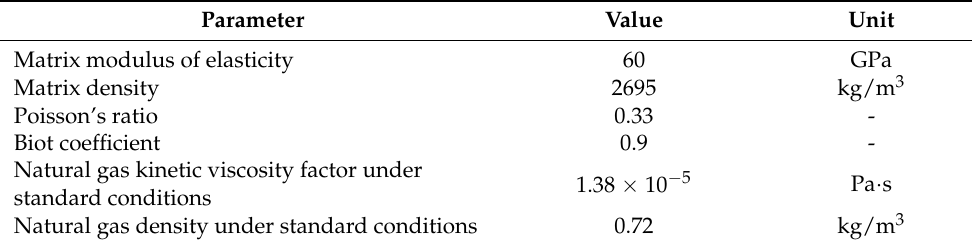
Table 2. Parameters of the numerical model. Parameter Value